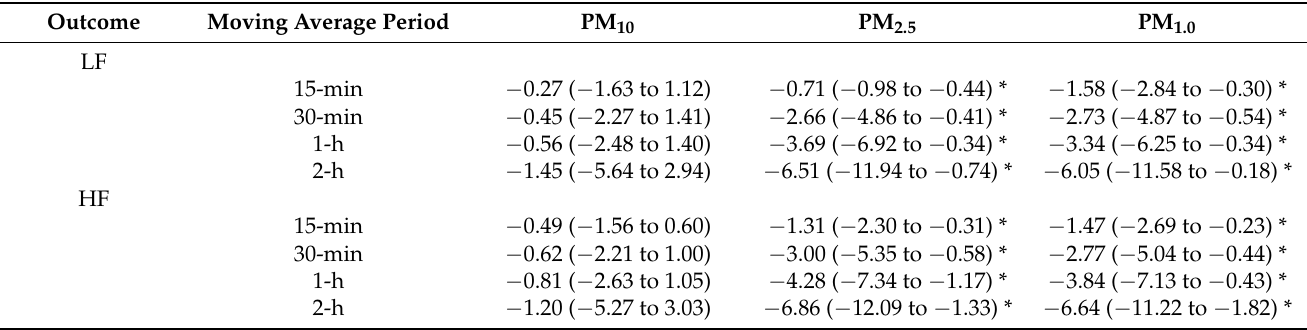
Table 3. Estimated percentage change (95% CIs) in LF and HF of frequency domain HRV indices by an interquartile range (IQR) † increase in PM exposure ( n = 54) ‡ .